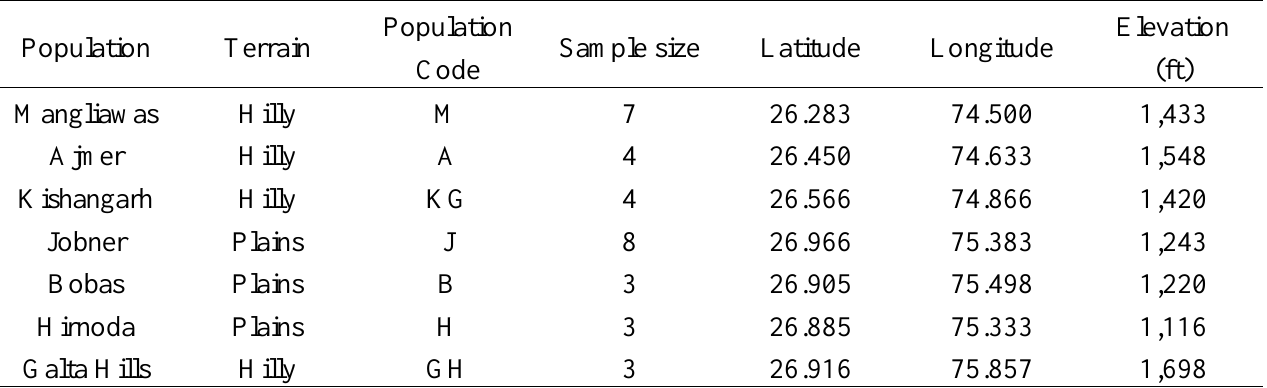
Table 1. Location of the sampled population of C . wightii